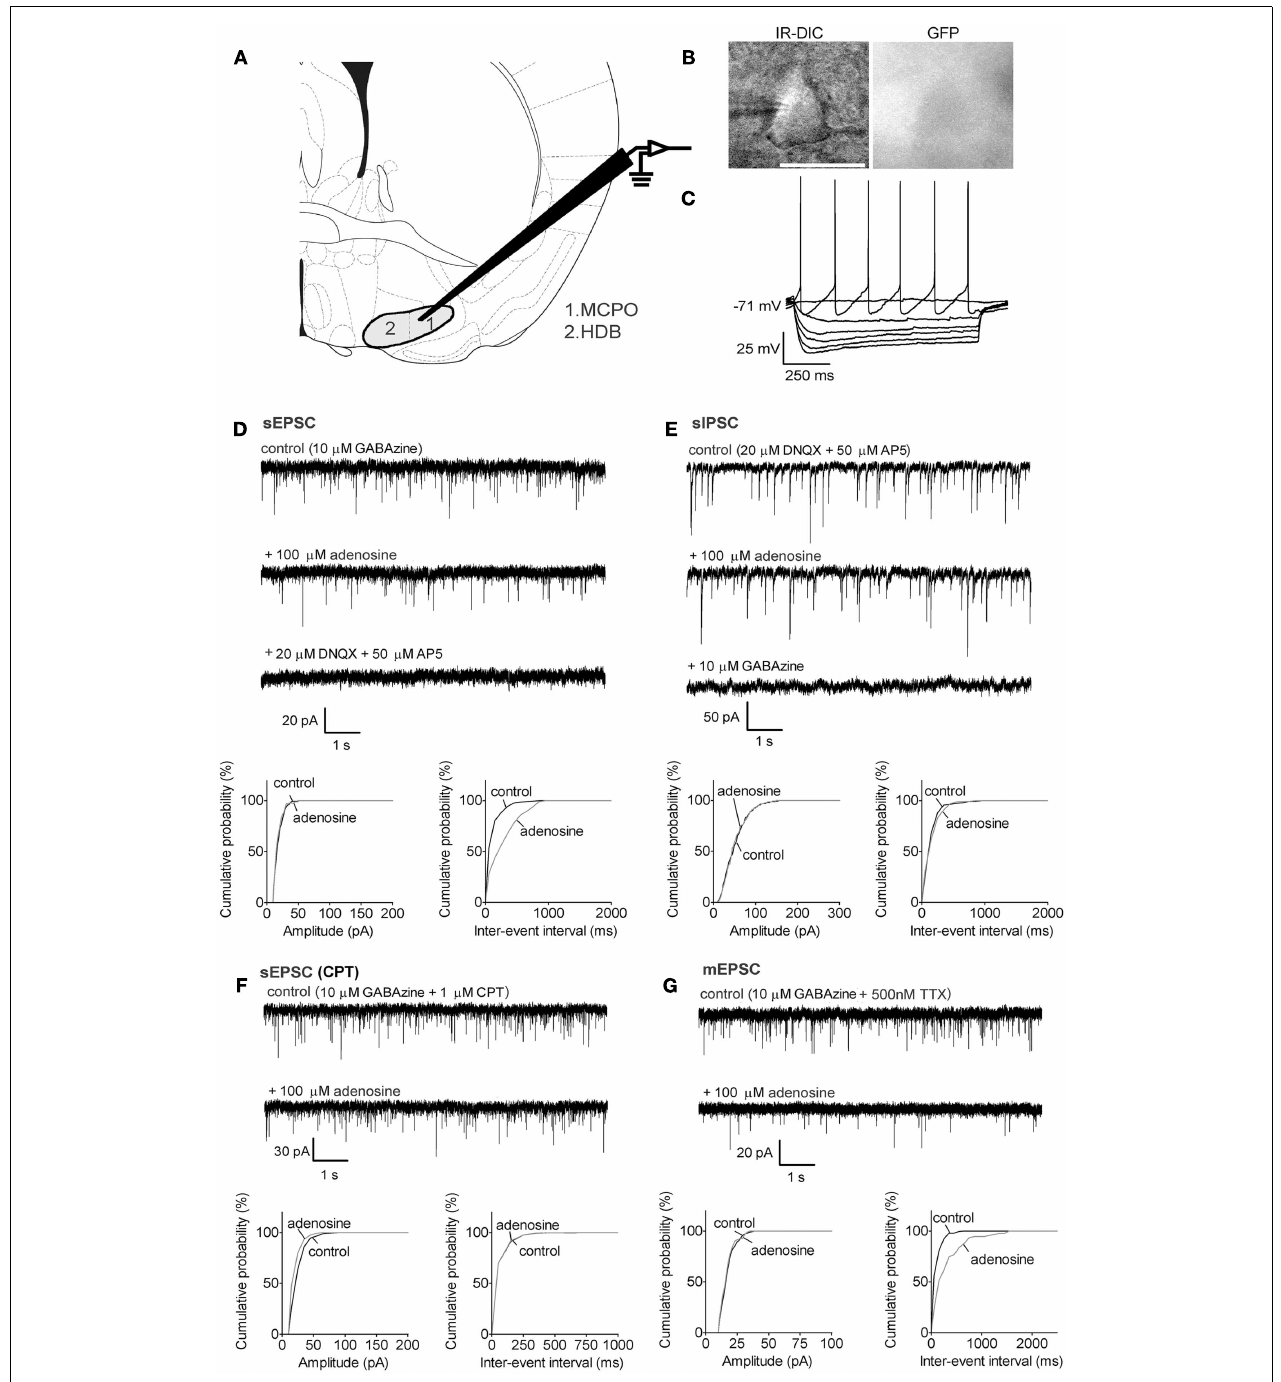
during current pulses (C) − 80 to + 16pA, − 16pA interval. Cholinergic neurons were silent at rest and exhibited slow firing and large afterhyperpolarizations when depolarized. In our previous study (McKenna et al., 2013) neurons with these properties were all identified as cholinergic by post hoc immunohistochemistry. (D) Adenosine reduced the frequency but not the amplitude of spontaneous excitatory postsynaptic currents (sEPSC).The GABA A receptor antagonist, GABAzine, was used to isolate excitatory events. (E) Adenosine did not affect the frequency or amplitude of spontaneous inhibitory postsynaptic currents (sIPSC).The ionotropic glutamate receptor ( Continued